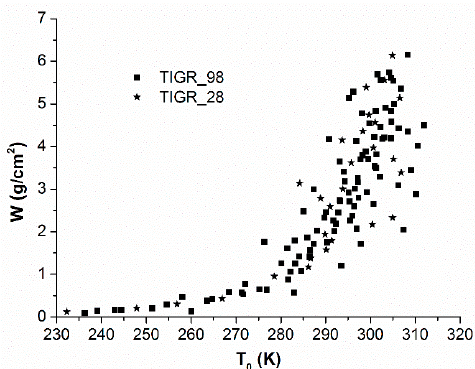
Figure 2. Plot of the total water vapour content (W) versus bottom layer atmospheric temperature (T 0 ) for the selected atmospheres. TIGR_98 were used for algorithm development, and TIGR_28 were used for algorithm validation.